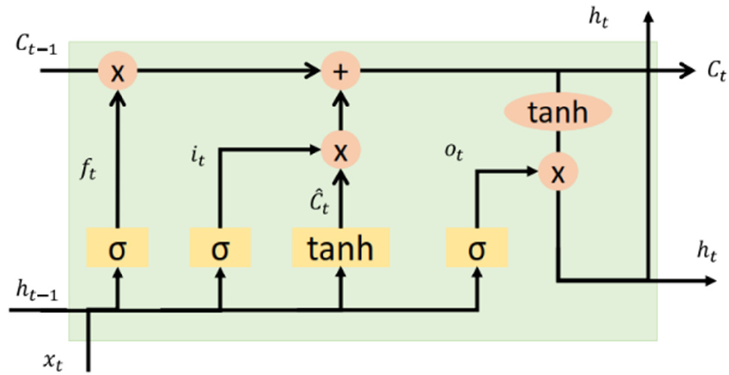
Figure 2. Base neuron LSTM [37].